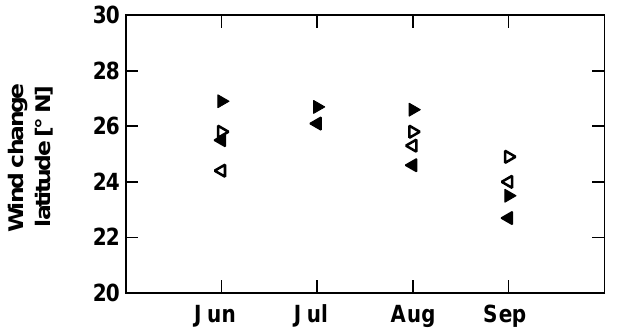
Figure 4. Latitude of the aircraft at the transition between eastward and westward flow in the UTAC for each flight during the sum- mer monsoon 2008. Arrows pointing to the right indicate flights from Frankfurt to Chennai; arrows pointing to the left indicate re- turn flights. Filled symbols represent the first round-trip flight se- ries; open symbols indicate the second (when applicable). For each of the seven pairs of flights the wind change (transition point) is about 1 ◦ further north on the flight to Chennai (when the aircraft cruise altitude is 1–2km higher) than on the return